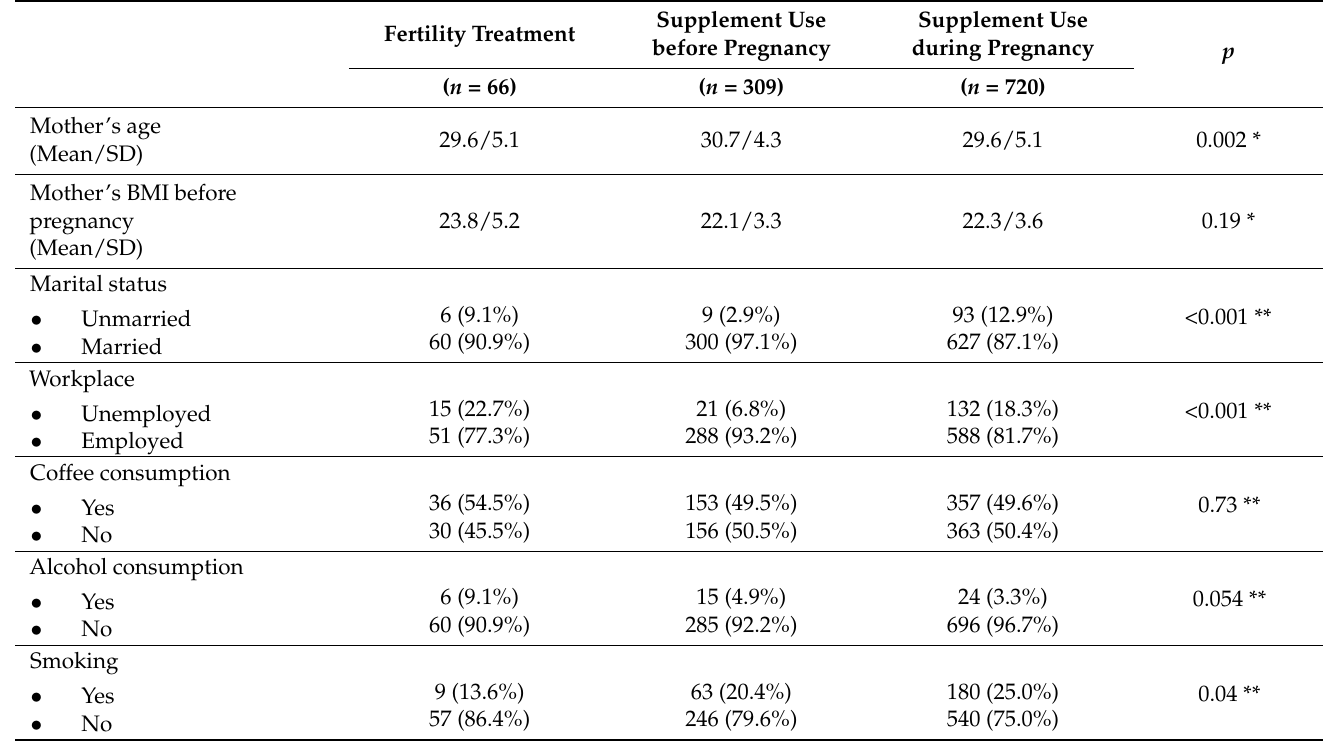
Table 1. Basic characteristics of women interviewed about vitamin supplement use before and during pregnancy and fertility treatment, T â rgu Mures, Romania, 2015–2016. Supplement Use Supplement Use Fertility Treatment before Pregnancy during Pregnancy